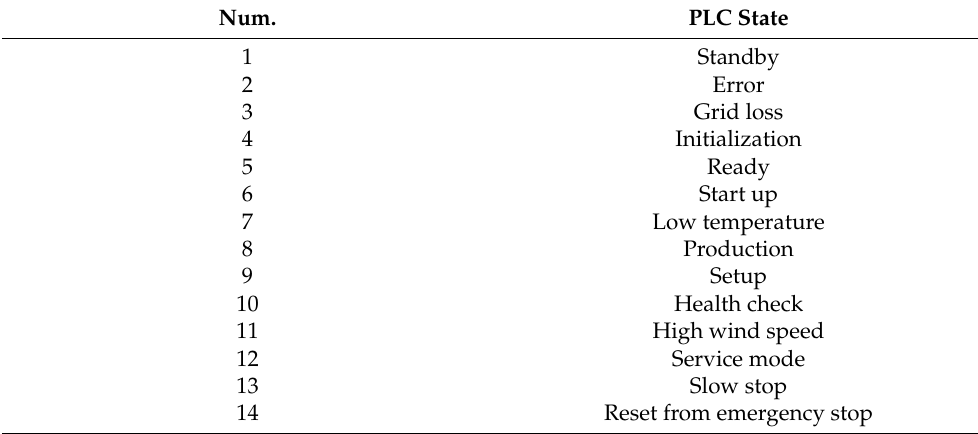
Table 2. PLC states of wind turbine.